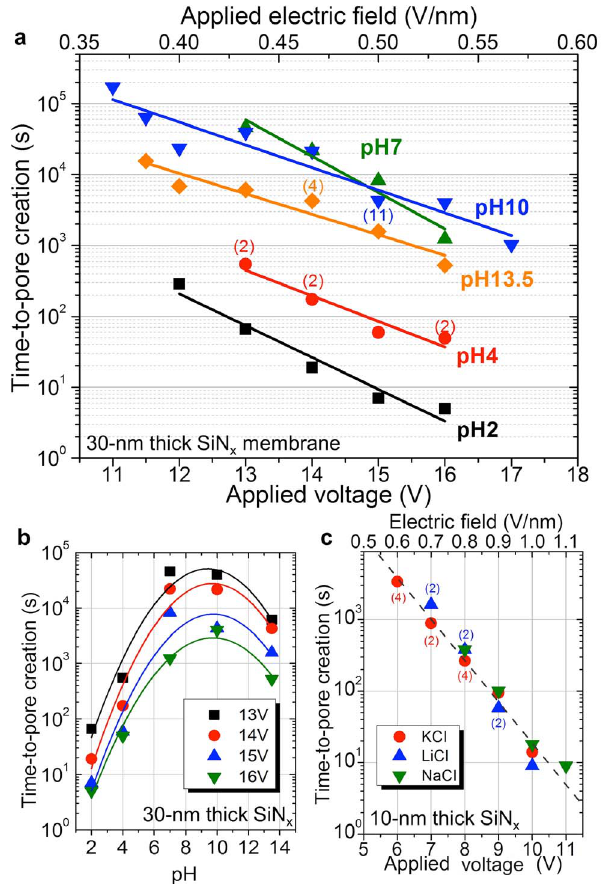
Figure 3. Time-to-pore creation as a function of experimental conditions. a) Semi-log plot of fabrication time of individual nanopores created in 30-nm-thick SiN x membranes in 1 M KCl buffered as indicated, versus the applied voltage and the calculated applied electric field. The number of separate nanopores each data point is averaged over is indicated in parentheses. The vast majority of nanopores plotted are sub-5-nm in size (i.e. , 7 nS). b) Semi-log plot of fabrication time versus pH for the data plotted in a). c) Semi-log plot of fabrication time of individual nanopores created in 10-nm-thick SiN x membranes in 1 M Cl-based electrolyte buffered at pH 10 for different cationic species versus the applied voltage and the calculated applied electric field. All 66 nanopores plotted are sub-5-nm in size (i.e. , 20